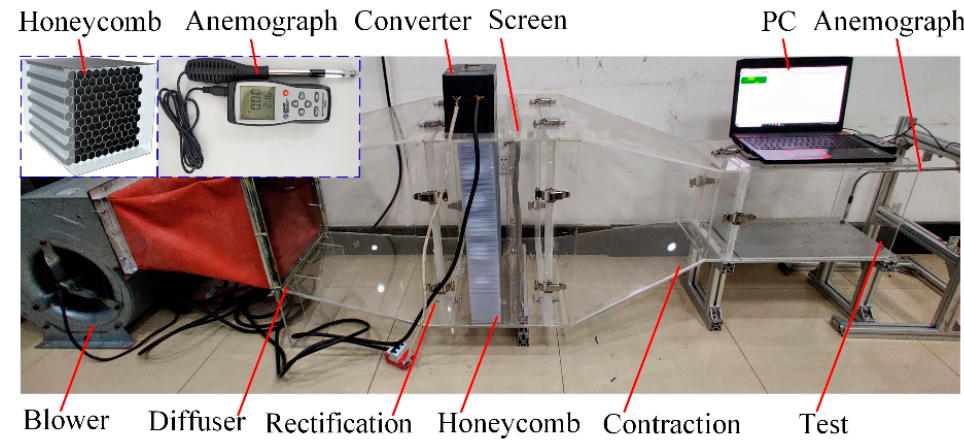
Figure 12. Wind tunnel experimental system.